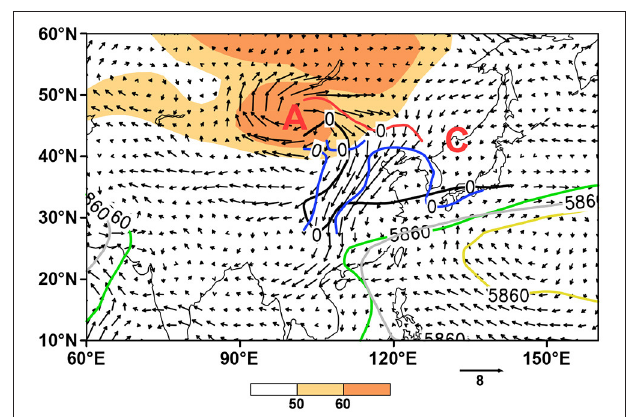
FIGURE 3 | Distribution of the ECH difference of extremely warm years between the warm and cold periods (shaded; units: gpm), 5,880-gpm contours (gray thick line indicates climate mean, green and yellow thick line for extremely warm years of warm period and cold period, respectively) and the 850-hPa wind anomalies difference of extremely warm years between warm and cold periods (vector; units: m s − 1; Letters A and C represent low-level anticyclone and cyclone anomalies, respectively.) Thick red line, blue thick line, and black thick lines mean the NECV southern boundaries (the zero-vorticity line) for extremely warm years of the warm period, cold period, and climate mean,